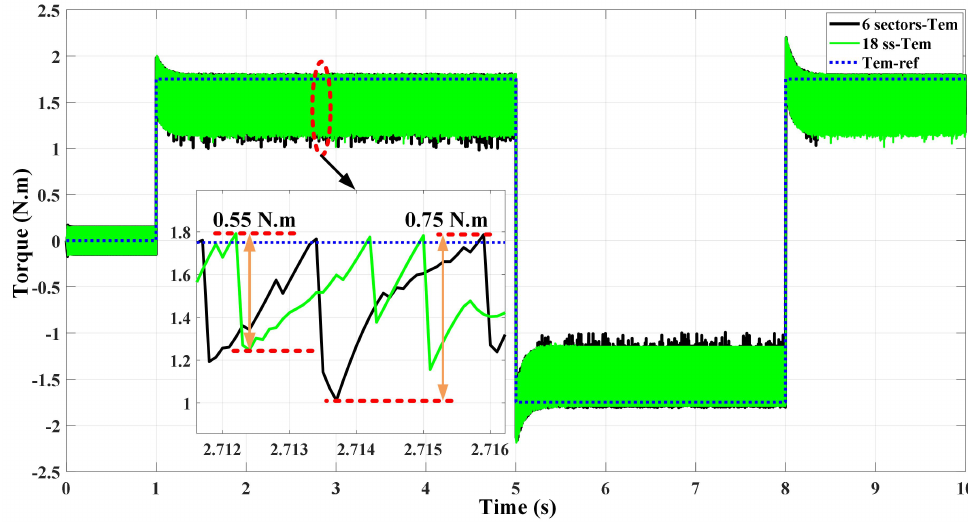
Figure 19. The torque response of both the classical and improved strategies at high speed is equal to the nominal speed.